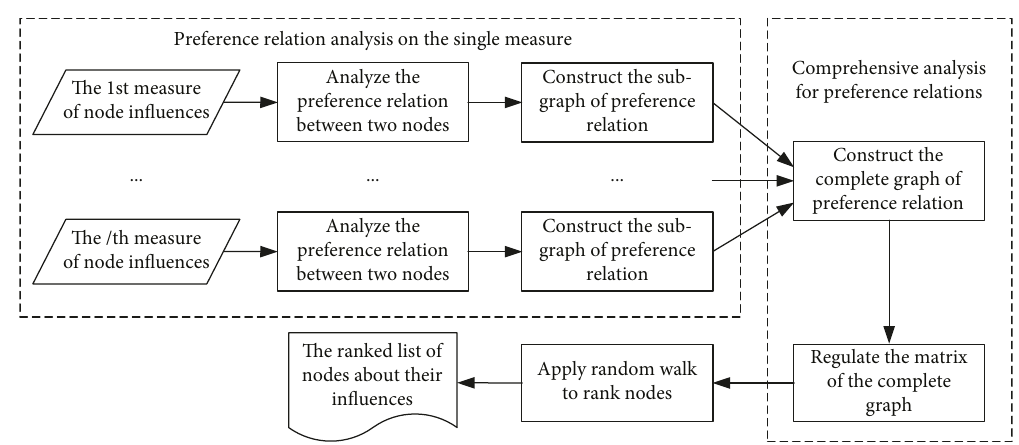
Figure 1: The overall framework for ranking nodes according to their in fl uences.